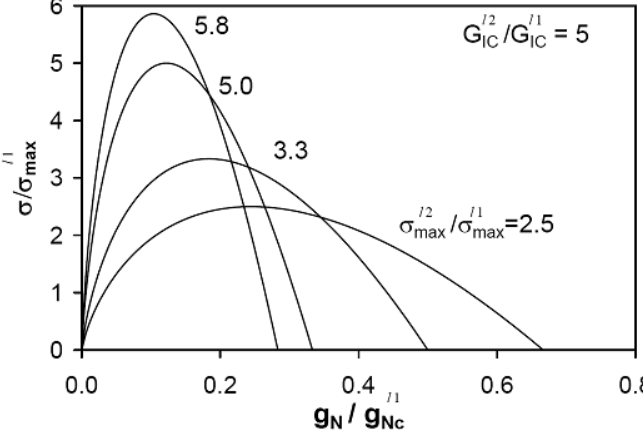
Figure 8: Shapes of the CZMs of the interfaces between the rods (level 2 or mesostructure).